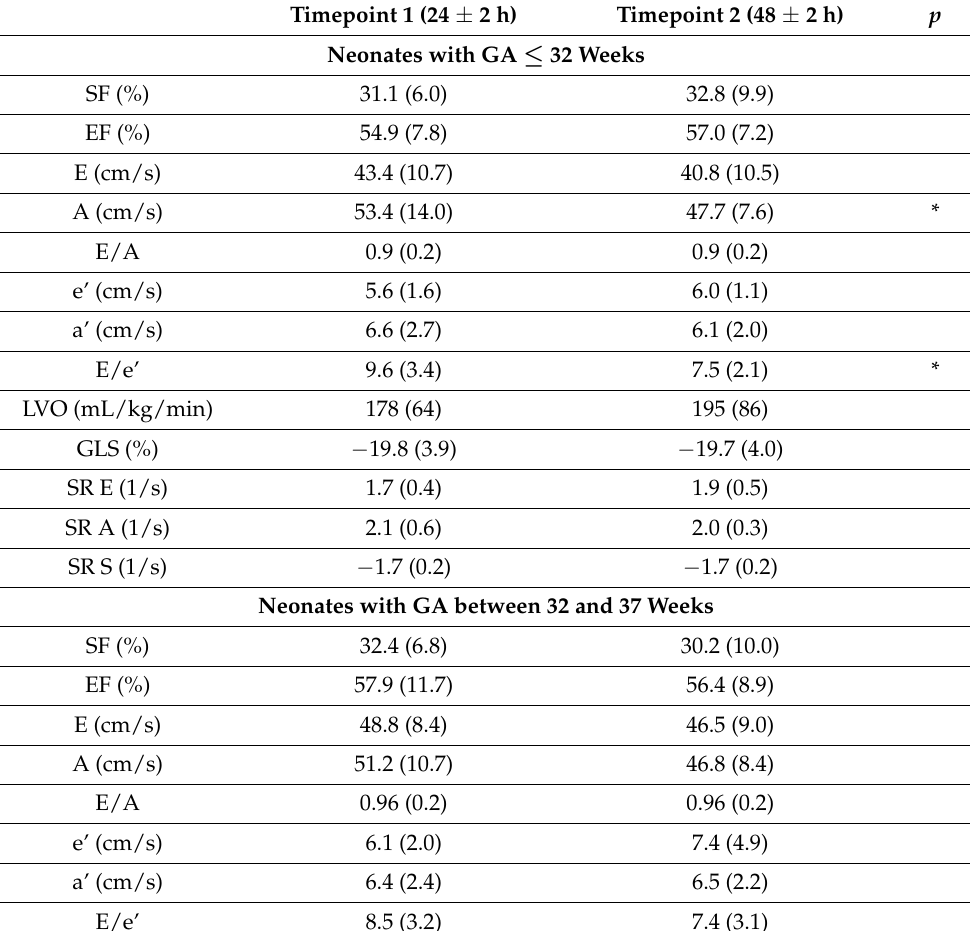
Table 6. Echocardiographic parameters at 24 and 48 h in the second cohort of